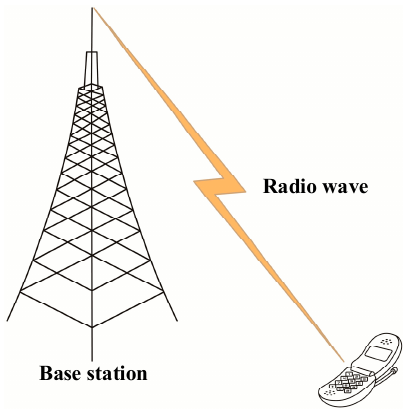
Figure 1. The common wireless communication system application scenario.